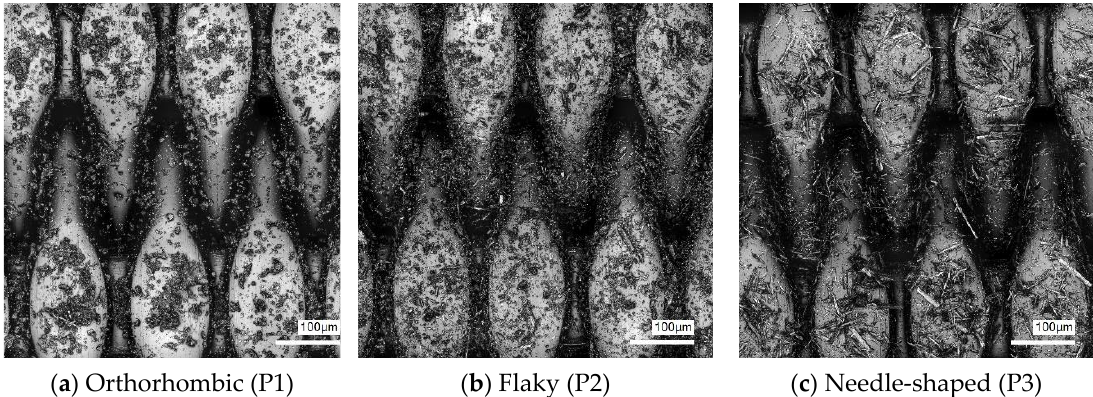
Figure 6 . ( a – c ) Separation of the different particle systems (P1–P3) for the 22 µm monofilament fabric (plain wave). Figure 6. ( a – c ) Separation of the different particle systems (P1–P3) for the 22 µ m monofilament fabric (plain